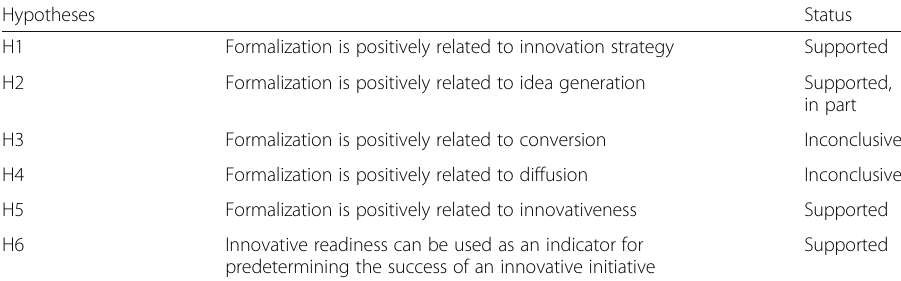
Table 3 An overview of the tested